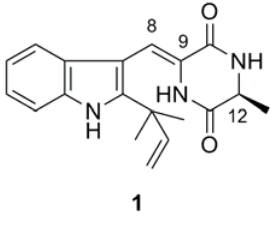
Figure 1. The structure of natural neoechinulin A ( 1